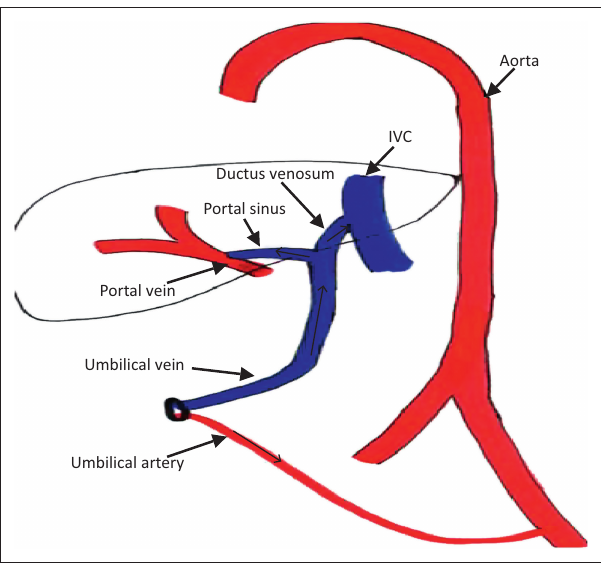
FIGURE 1: Schematic drawing demonstrating the umbilical vessels and their connections to the systemic circulation during the neonatal period.